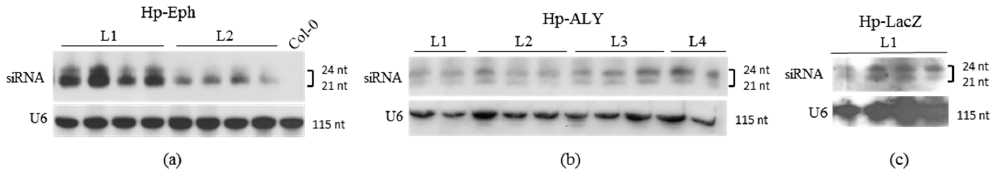
Figure 2. Small interfering RNA (siRNA) detection in A. thaliana ( a ) Hp ‐ Eph; ( b ) Hp ‐ ALY and ( c ) Hp ‐ LacZ. Total RNA was extracted from four ‐ week old seedlings of the T1 progeny of transgenic A. thaliana . Each lane was loaded with 20 μ g of total RNA and the blots were hybridized with digoxigenin (DIG) ‐ labeled probes, except in ( b ), where radioactive probes were used to detect U6 RNA and ALY ‐ siRNA. The other blots were further stripped and hybridized with a DIG ‐ labeled U6 probe as a loading control. Col ‐ 0: total RNA extract from a non ‐ transformed A. thaliana Col ‐ 0 plant. Table 1. Silencing efficiency of Eph in whole M. persicae using different RNA interference (RNAi)-based methods. Plant or RNA Relative Fold Change Eph -mRNA in Aphid Feeding Source Exp. AAP b Concentration Whole M. persicae